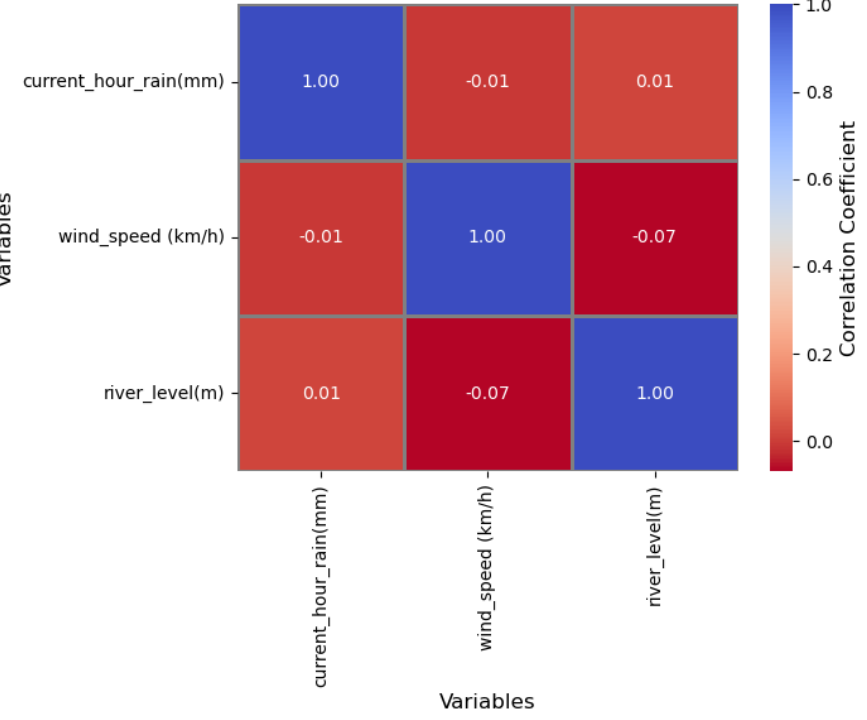
Figure 17. Correlations among rainfall, wind speed, and river levels in one location for the stated